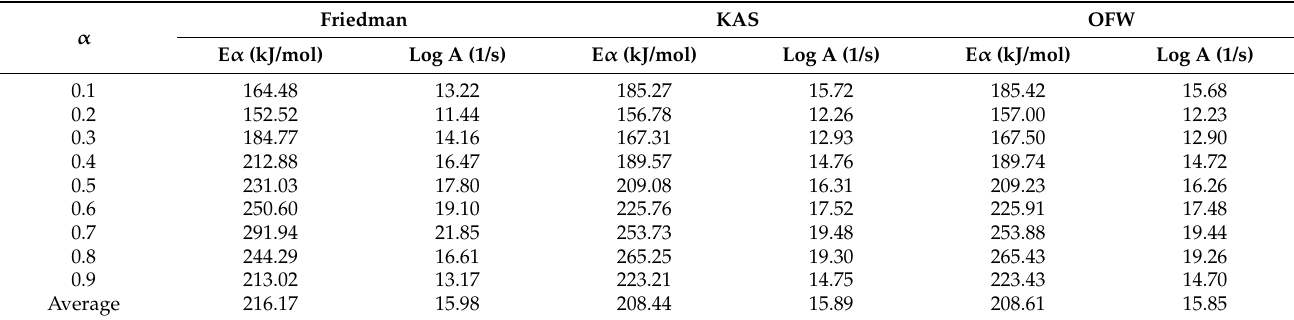
Figure 5. Plots for determination E α of AIW pyrolysis using: ( a ) Friedman; ( b ) KAS; ( c ) OFW. Table 7. Values of activated energy according to different methods.